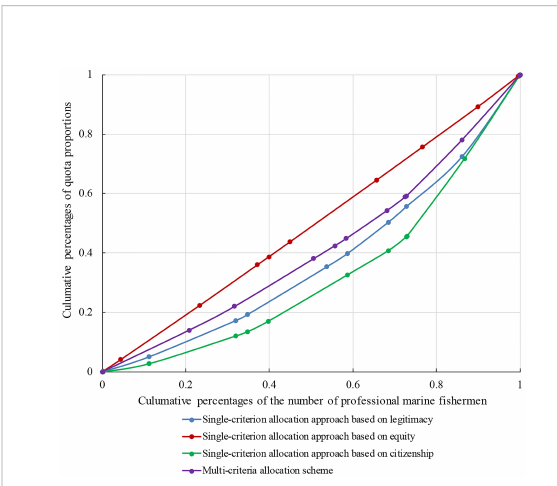
FIGURE 3 The Lorenz curves of allocation results derived from the schemes using single-criterion and multi-criteria allocation approaches.